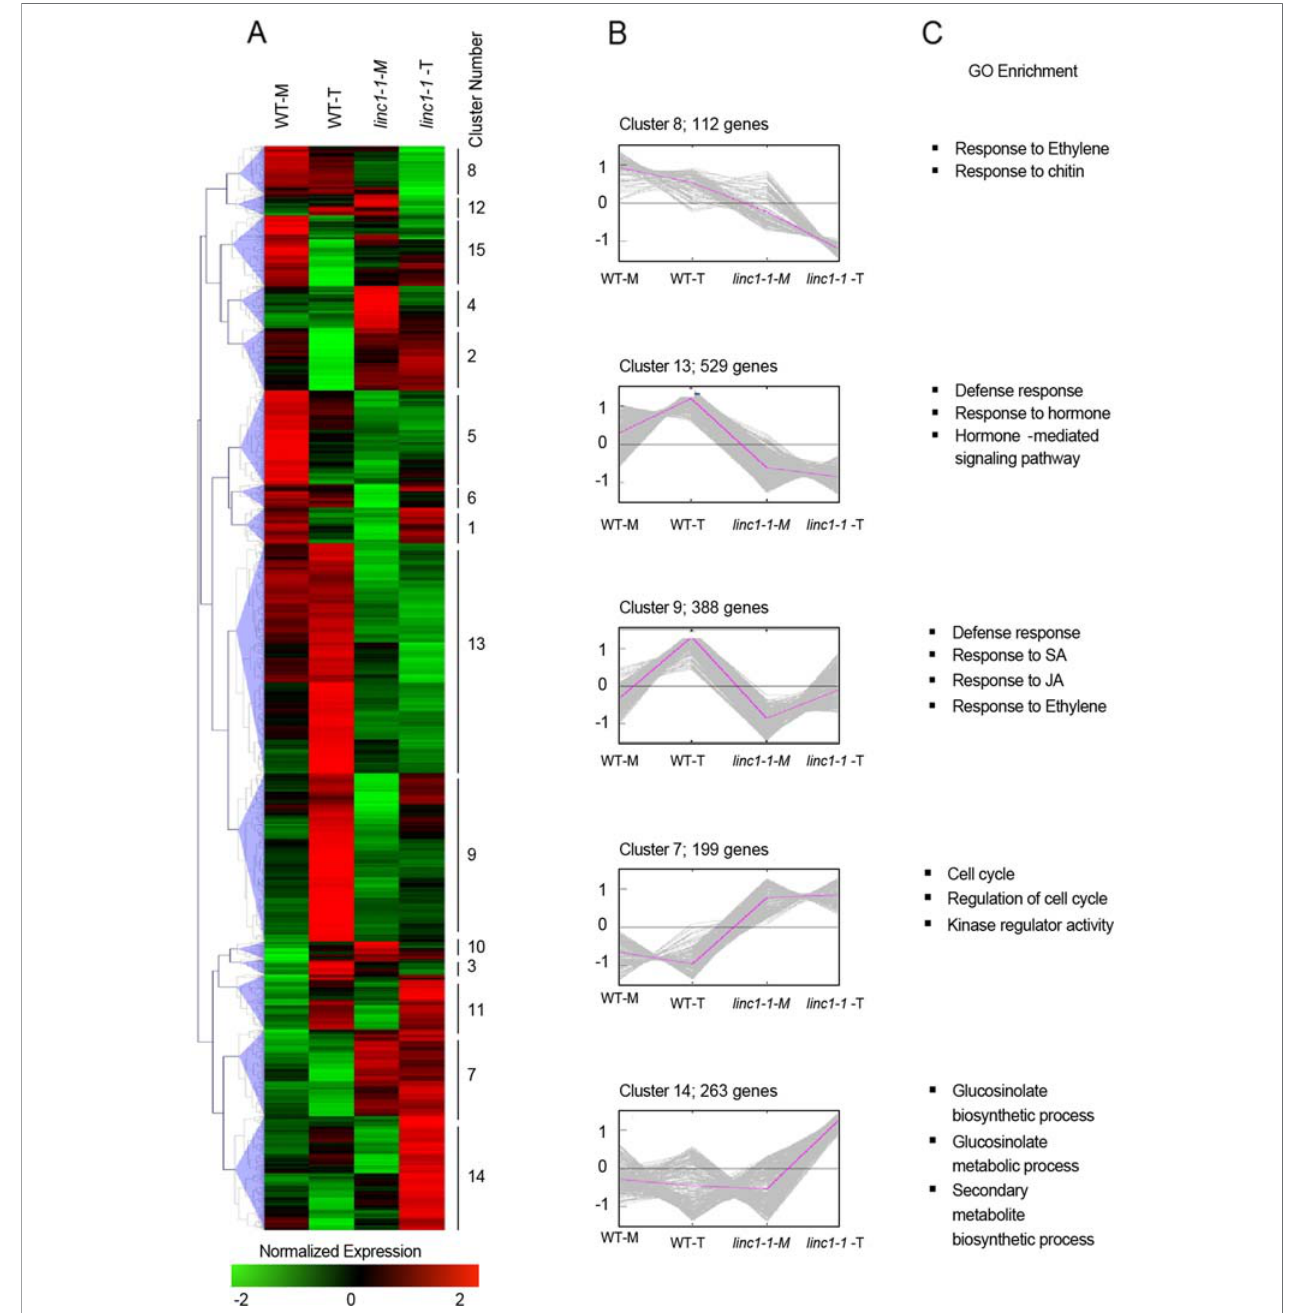
FIGURE 2 | LINC1 globally regulates expression of Pst hrcC − induced genes. (A) Heat map of mock and Pst hrcC − induced genes in wild type and linc1-1 plants. The original FPKM values were subjected to data adjustment by normalized genes/rows and hierarchical clustering was generated with the average linkage method using MeV4.0. Red color indicates relatively high expression, and green indicates relatively low expression. (B) Expression pattern of the gene clusters de fi ned in panel A . (C) Enrichment of genes with GO terms of signi fi cantly enriched gene families. The fold enrichment was calculated based on the frequency of genes annotated to the term compared with their frequency in the